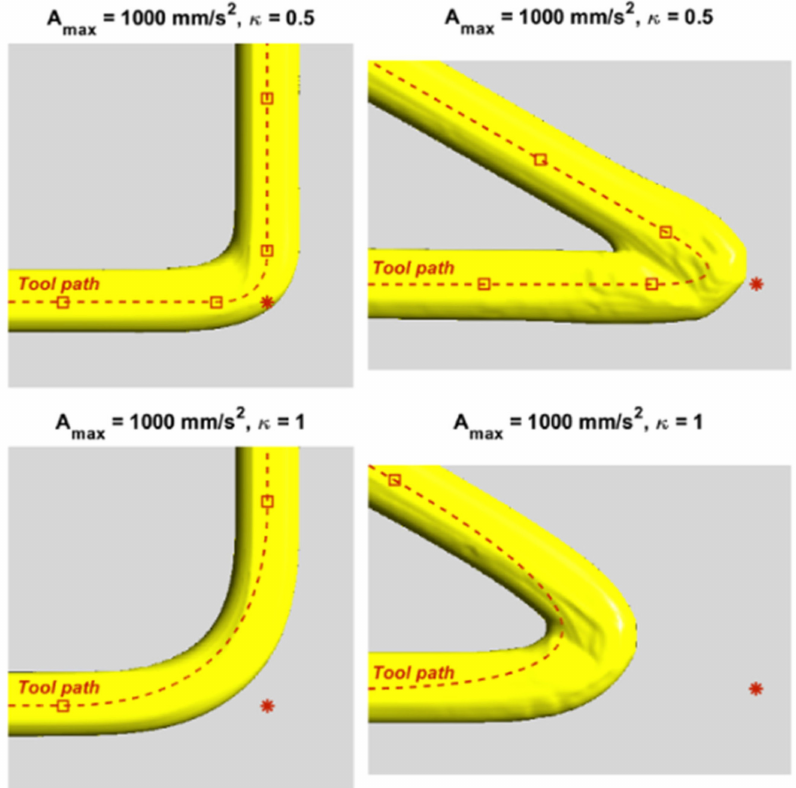
Figure 4. Successful fabrication of 90 ◦ and 30 ◦ corners reproduced with permission from [25]. Elsevier,